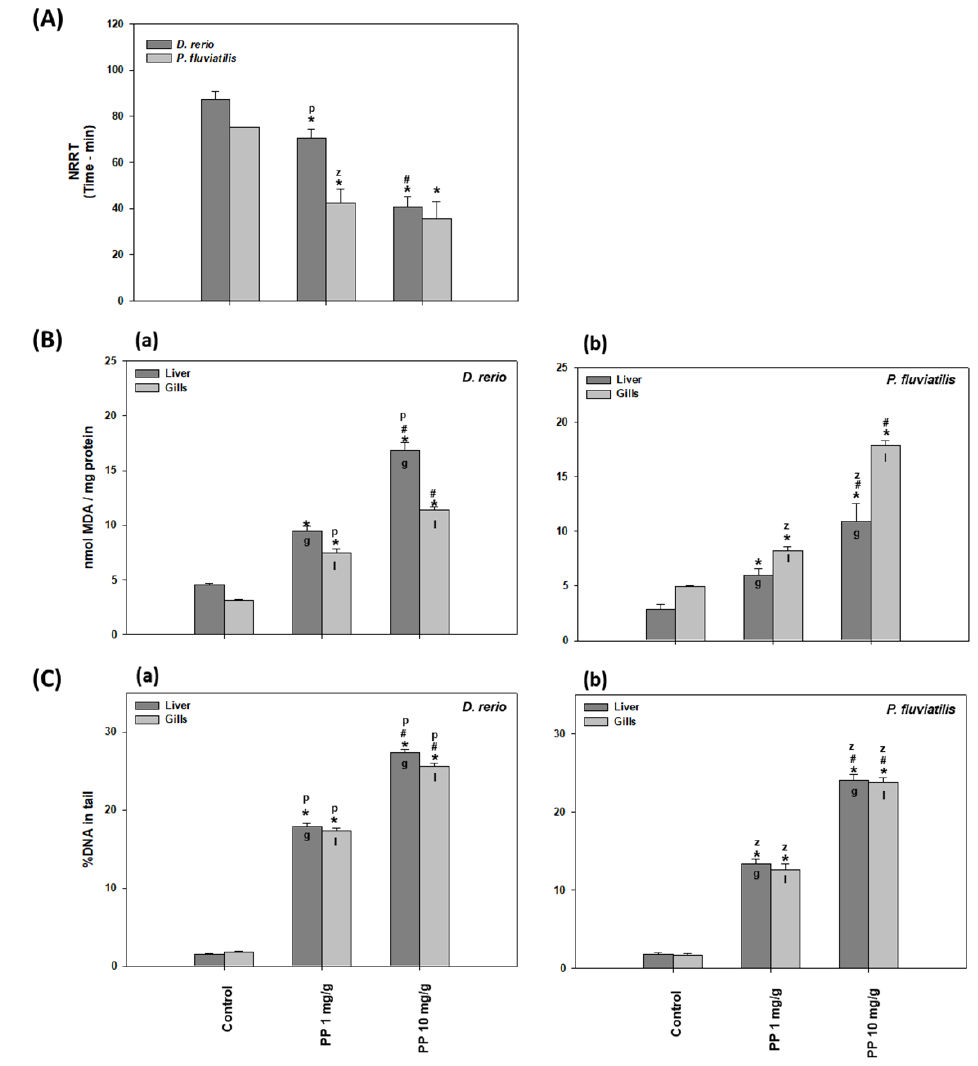
Figure 2. ( A ) NRRT levels in the Danio rerio and Perca fluviatilis control and treated with 1 mg/g and 10 mg PP-MPs/g dry food. ( B ) MDA concentrations (mean ± SD nmol/mg protein) and ( C ) percentage (%) of DNA damage in the tail (mean ± SD) in the liver and gills of the Danio rerio ( a ) and Perca fluviatilis ( b ) control and dietary exposed to 1 mg PP-MPs /g and 10 mg PP-MPs/g dry food. %DNA in tail and olive moment in positive control data (1 µ M H 2 O 2 ) were 28.3 ± 5.2 and 40 ± 6.3, respectively. Asterisk (*) denotes significant differences ( p < 0.05) compared to the control group, dash (#) denotes significant differences ( p < 0.05) between the two examined concentrations: 1 mg PP-MPs/g and 10 mg PP-MPs/g, lower case letters “z” and “p” denote significant differences ( p < 0.05) between the two examined species D. rerio and P. fluviatilis, respectively, while lower case letters “g” and “l” denote within species significant differences ( p < 0.05) between the gills and liver,